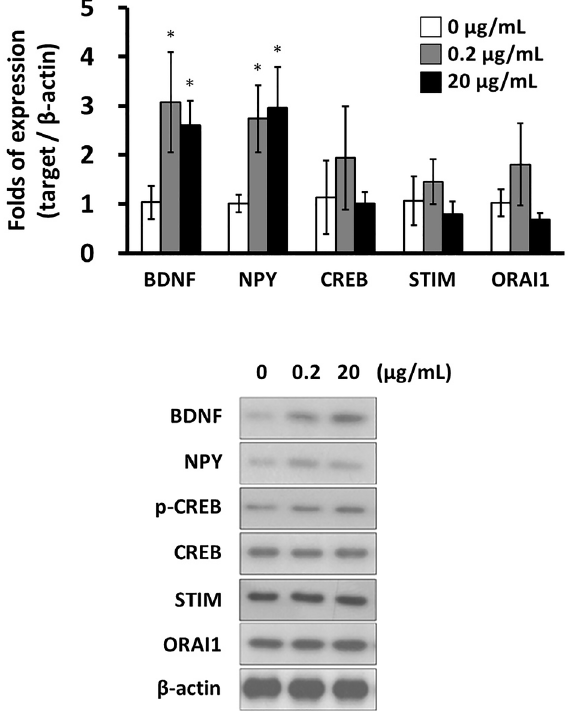
Figure 3. mRNA levels (n=3, top ) and protein levels (n=3, bottom ) of brain-derived neurotrophic factor (BDNF), neuropep- tide Y (NPY), cAMP-response element binding protein (CREB), stromal interaction molecule (STIM), and calcium release-activated calcium channel protein 1 (ORAI1) in hippocampal tissues from kainic acid-induced epileptic rats with different treatment time of scorpion venom heat-resistant peptide. Data are reported as means ± SD. *P o 0.05; **P o 0.01 (Mann-Whitney